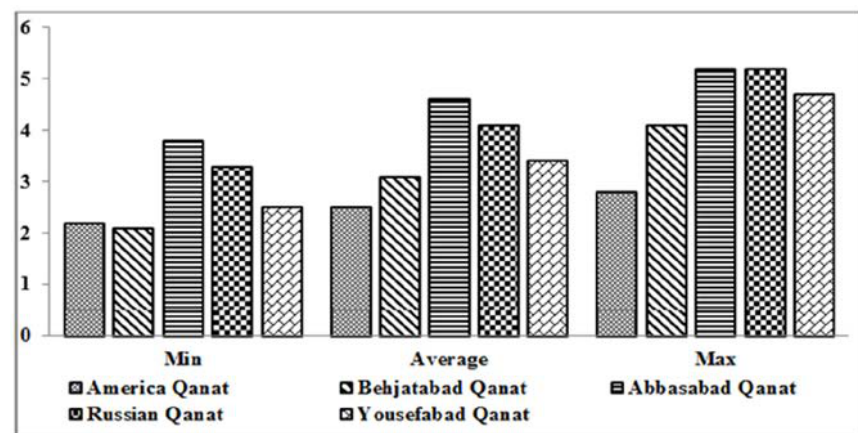
Fig. 13: SAR level of the studied aqueducts